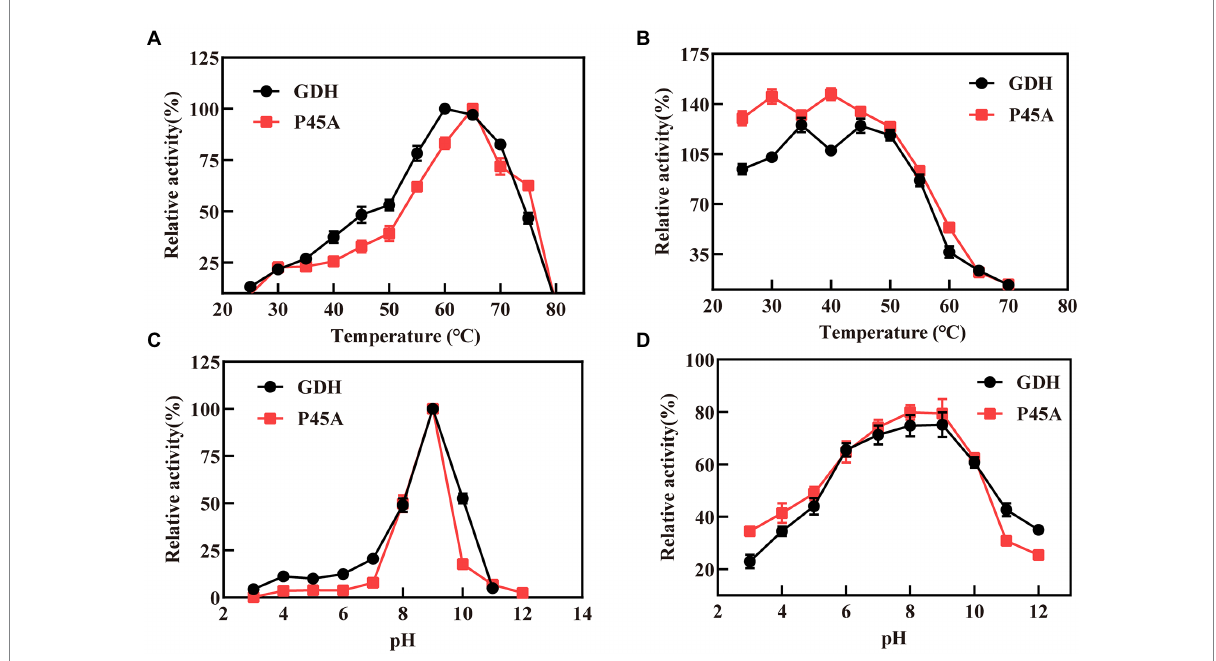
FIGURE 5 Characteristics of GDH and P45A. (A) Effect of different temperature values on the activity of GDH and P45A; (B) The residual activity of GDH and P45A after incubated at various temperatures for 20 min; (C) Effect of different pH values on the activity of GDH and P45A; (D) The residual activity of GDH and P45A after incubated at various pH values for 20 min. The results are expressed as the mean ± SD ( n =